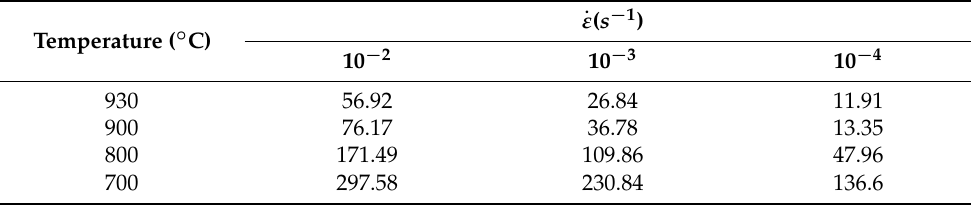
Table 3. Flow stress data from the tensile tests at ε =